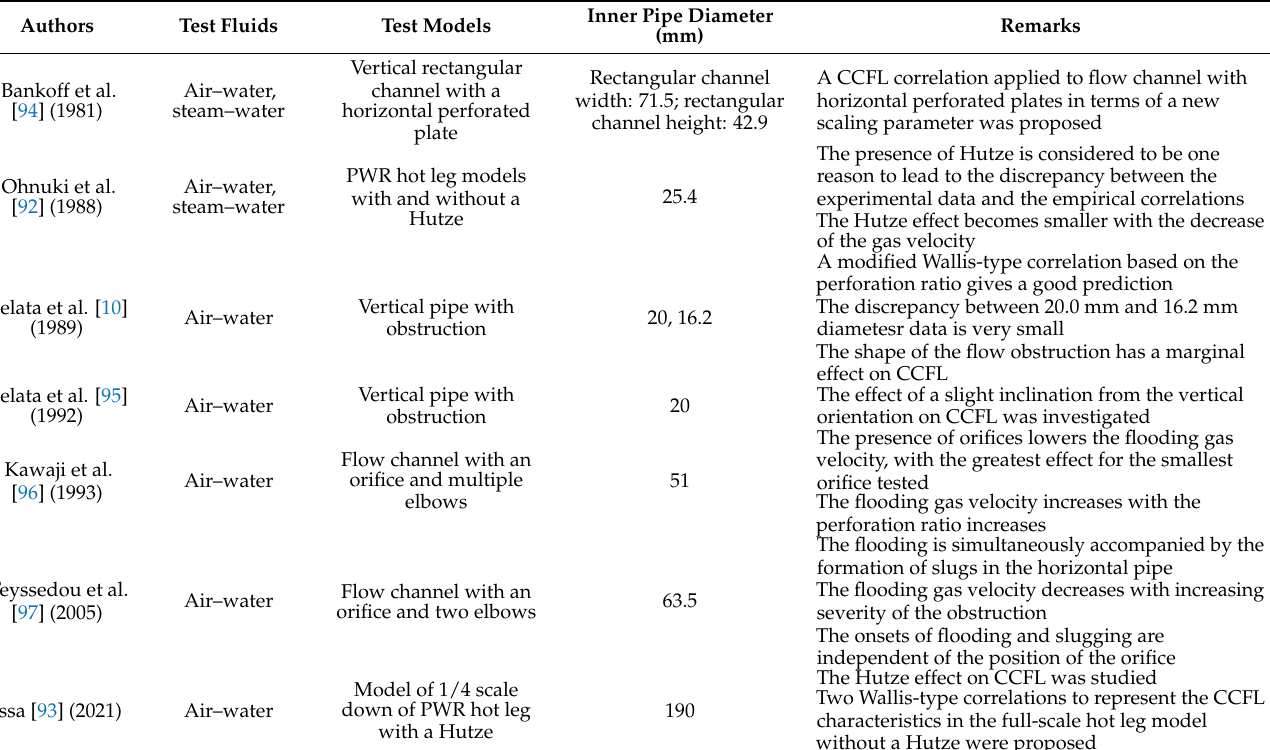
Table 8. Summary of the experimental investigations on the CCFL in the flow channel with